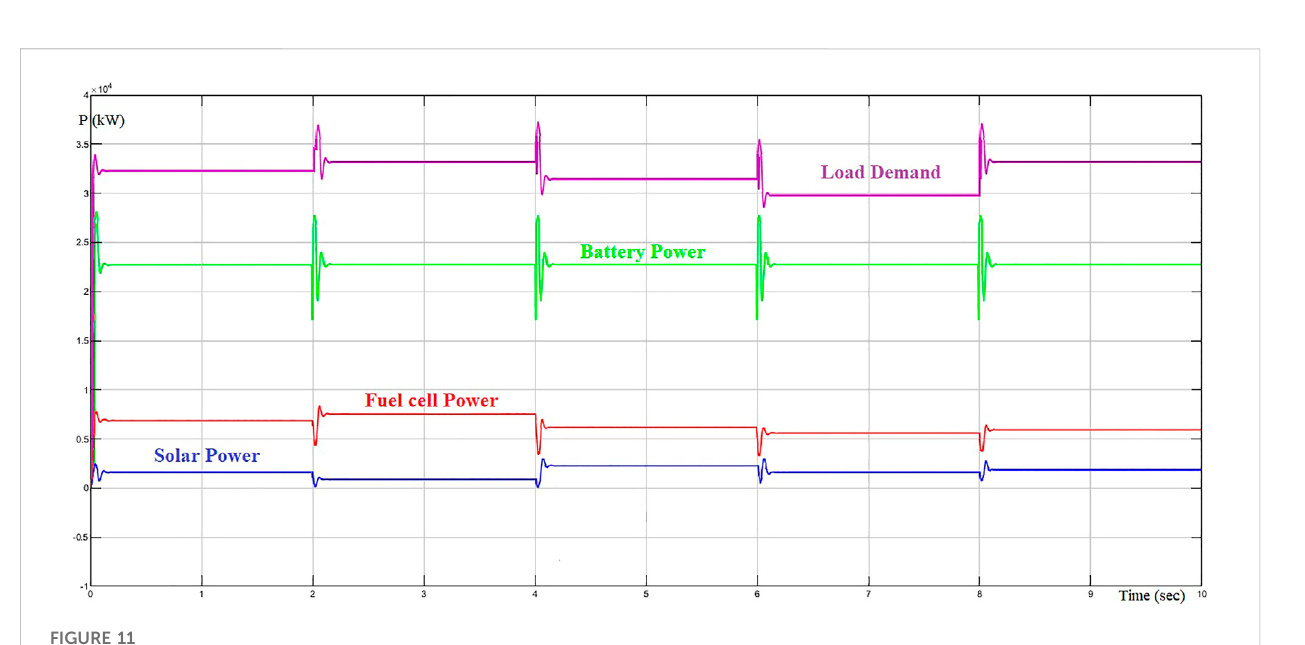
FIGURE 11 Power management based on varying load